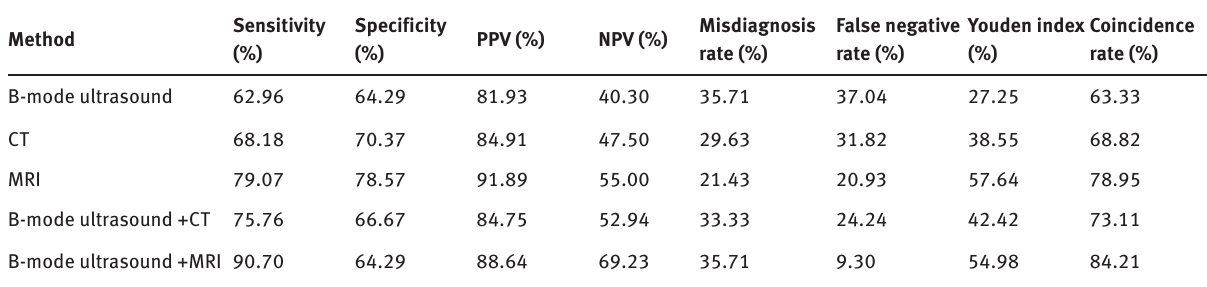
Table 2: Diagnostic Indicators of B-Mode Ultrasound, CT and MRI Examinations to the Myometrial Infiltration of Endometrial Cancer